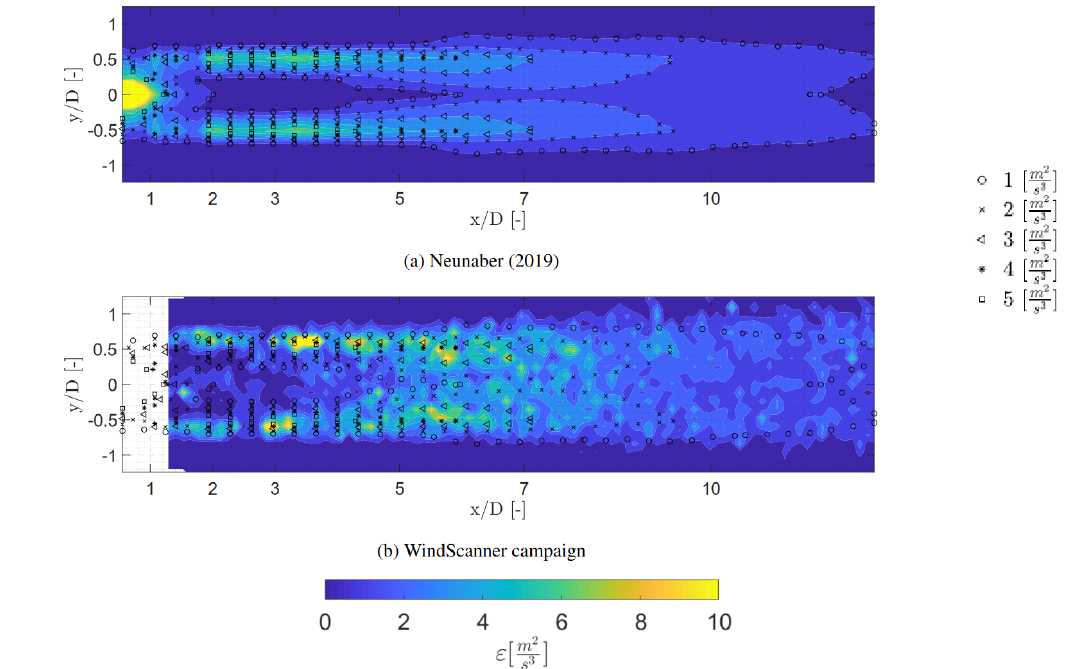
Figure 14. Comparison of the profiles of the averaged energy dissipation rate at 1, 2, 3, and 5 D between the WindScanner measurements and the hot-wire measurements at Neunaber (2019). Both measurements were conducted with no grid at U = 7 . 5ms − 1 . Lines with a marker indicate the contours at U = [ 0 . 6 , 1 . 2 , 1 . 8 ] ms − 1